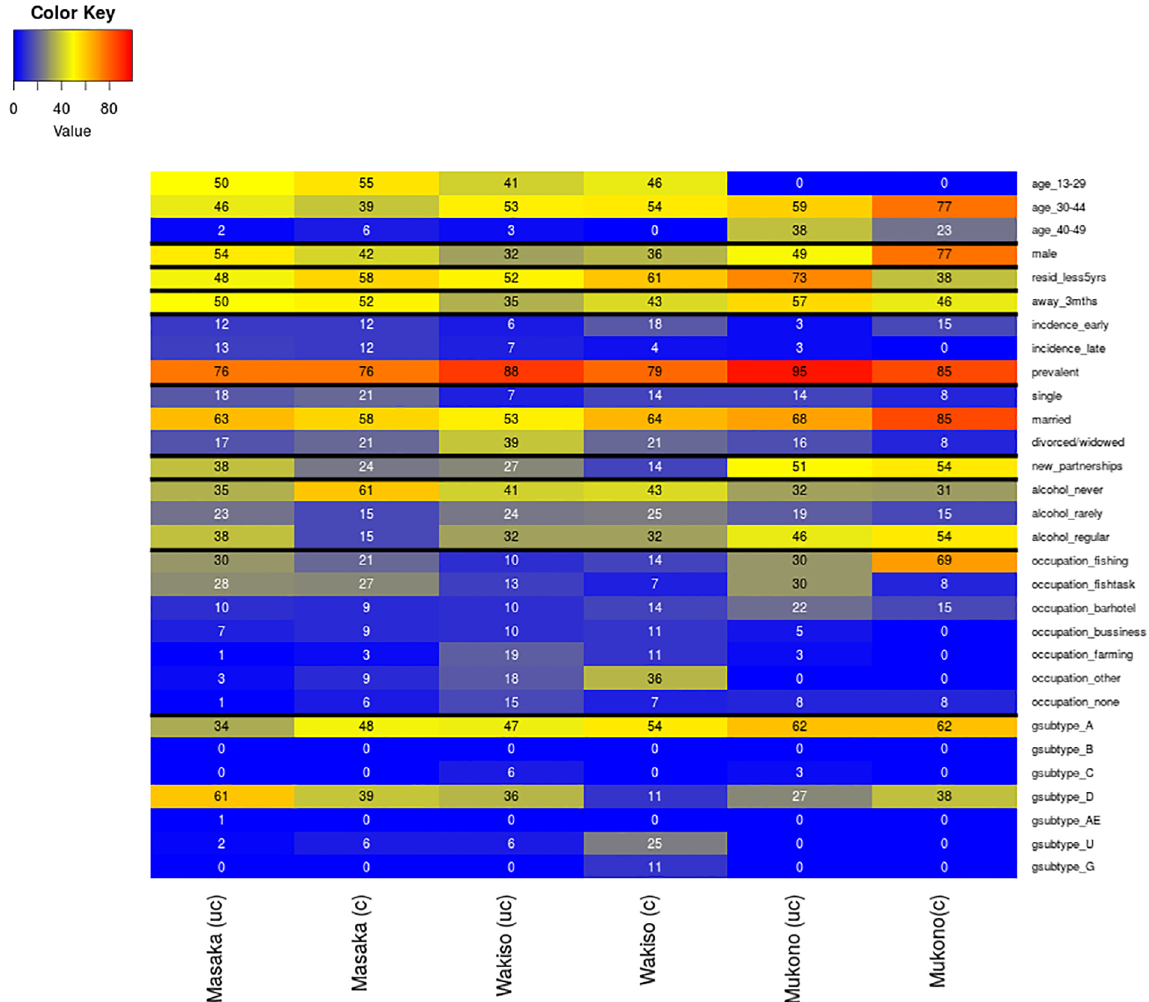
Fig 6. Heat map depicting clustering proportions of individuals sequenced 34 clusters (n = 283) stratified by baseline characteristics. The x-axis representsdistrict, uc is un-clustered, c is clustered. The columns list on the y-axis are individual characteristics at study initiationand subsequent columns are the proportions clusteredor un-clustered by district. Proportions are shown as a heat map to represent increasing proportions. Cells were colourcoded with slidingcoloursas follows: blue corresponds to a low number of clustering, yellow corresponds to an intermediate amount of clusteringand red correspondsto high level of clustering. Note that individuals in Masaka, Wakiso and Mukono; 2,2,1 had missing age, 25,3,1, had durationresident in area missing, 2,2,1 had missing marital status, 24,3,1 had missingoccupation, 7,3,1 had alcoholuse missing, 11,9,1 had partnerships missing, 7,3,1 had away 3 months missing and the remainingcharacteristics had none missing.